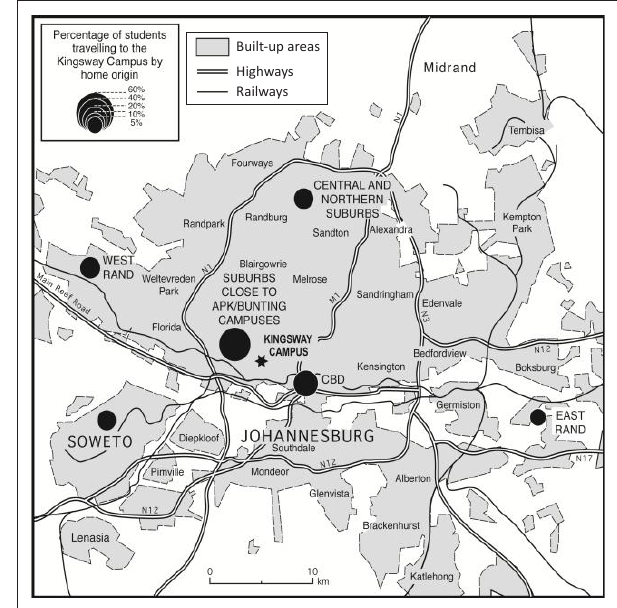
FIGURE 3: Origin of Auckland Park Kingsway Campus students.